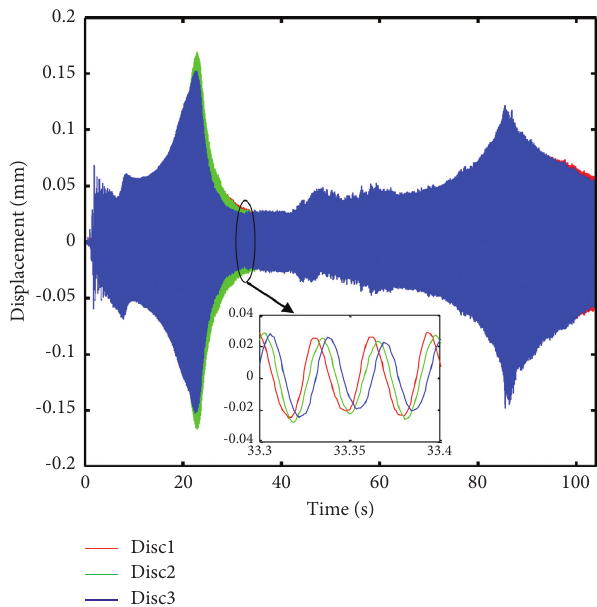
Figure 6: Vibration displacement of three discs while the rotor is speeding up.